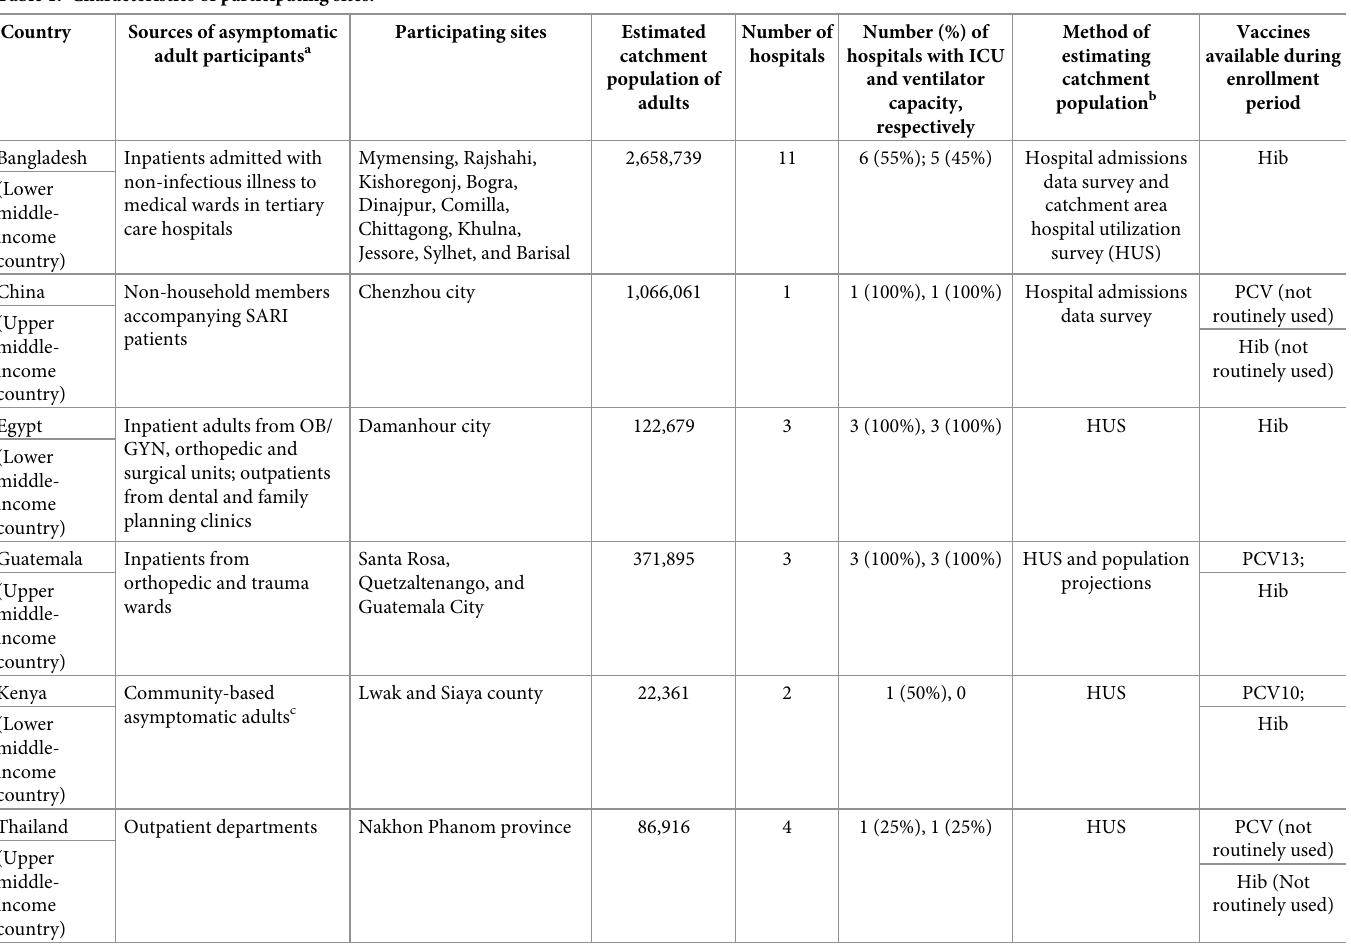
Table 1. Characteristics of participating